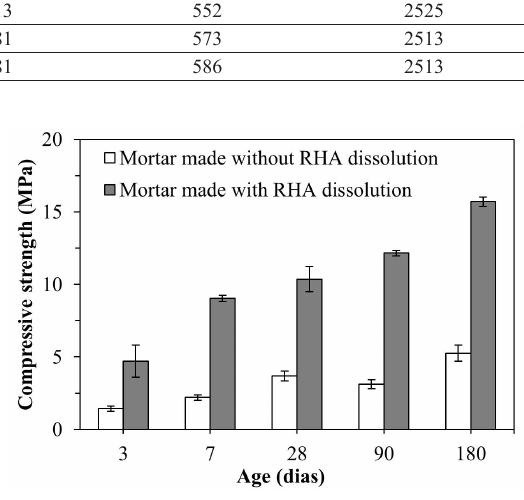
Table 4. Characteristics of the one-part AAB produced considering the theoretical SiO Sample